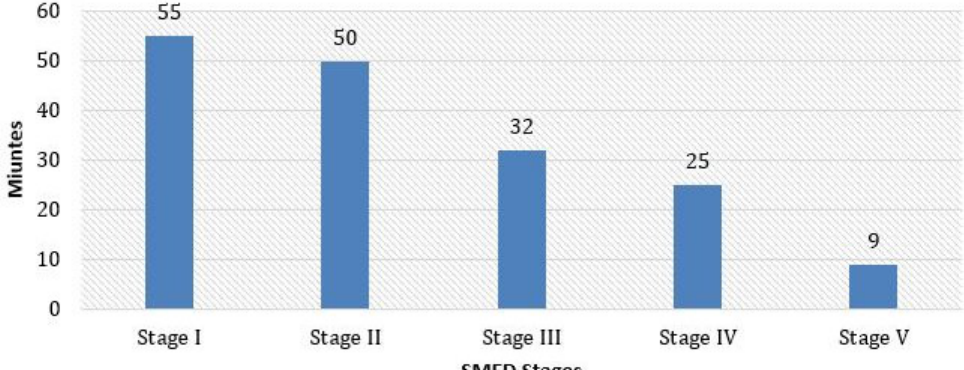
Figure 5. Changeover